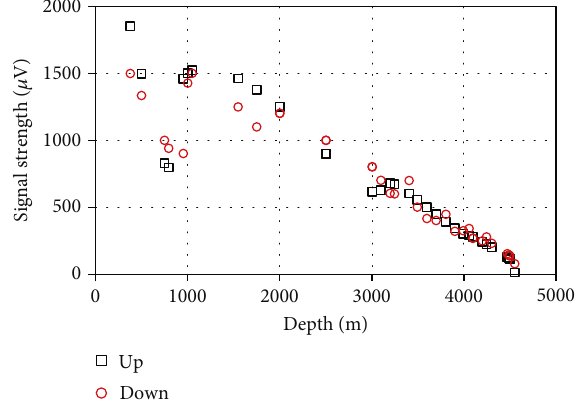
Figure 6: The relationship between the downhole depth of the downhole tool and the received signal strength of the wellhead tool in Well